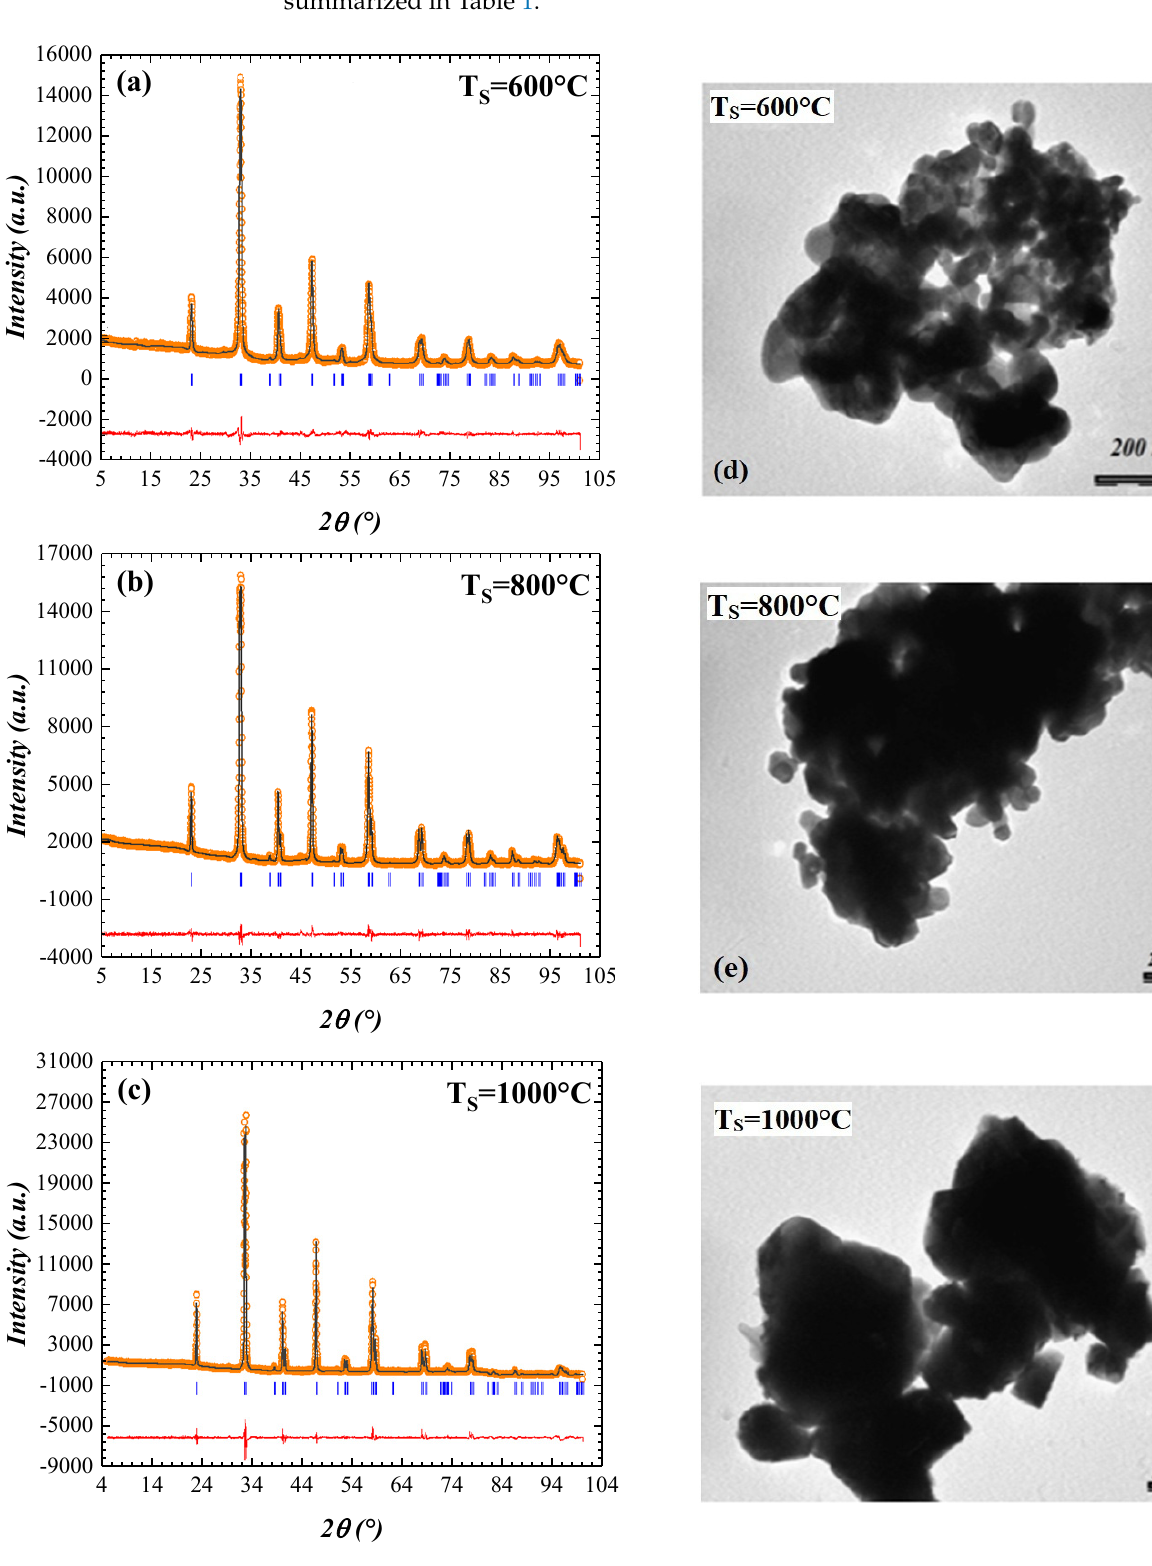
Figure 1. X ‐ ray diffraction patterns and Rietveld refinement of the La 0.9 Sr 0.1 MnO 3 system sintered at 600 ( a ), 800 ( b ), and 1000 °C ( c ). TEM micrographs of the sintered samples (T S = 600 °C ( d ), 800 °C( e ), and 1000 °C ( f )) for the La 0.9 Sr 0.1 MnO 3 system.